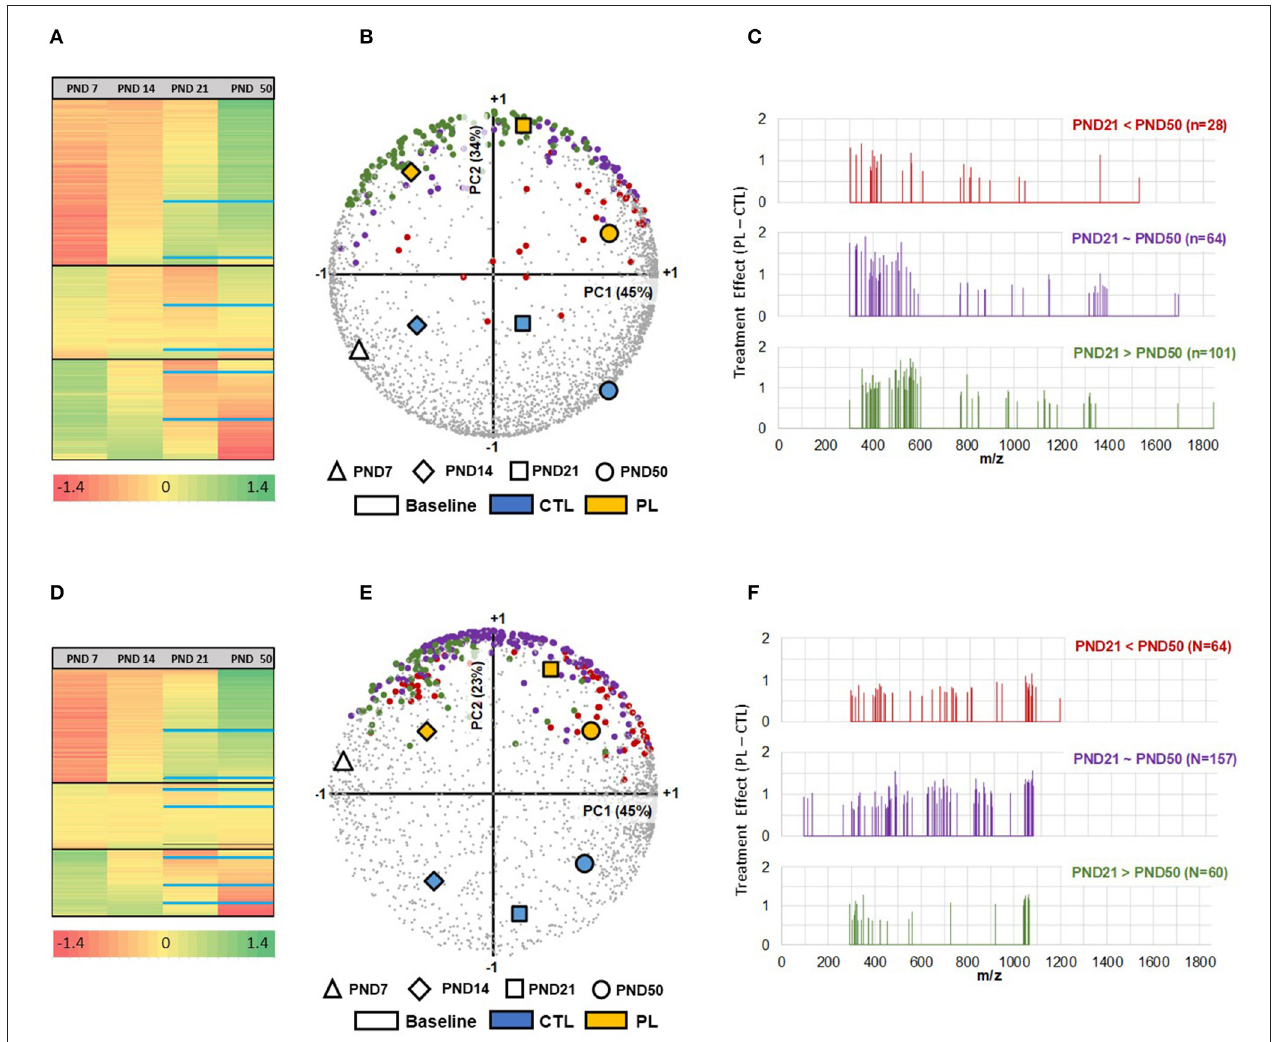
FIGURE 2 | Neurodevelopmental changes in brain lipidome and the impact of the PL supplementation. (A,D) In total, three developmental clusters (increasing, no change, and decreasing with age) of brain lipidome were detected using HCA, shown for positive and negative ionization mode, respectively. The black solid lines divide the three clusters within the HCA heatmap. Within each cluster, 3 additional subclusters were identified, divided by blue solid lines within each cluster, for PND 21 and PND 50. PCA Biplot of first and second principal components with Treatment x Age positioned for m/z detected in (B) positive ionization mode ( n = 3,108) and (E) negative ionization mode ( n = 2,133). PC1 (plotted on x-axis), accounting for 45% in both modes, is highly associated with developmental age, whereas PC2 (plotted on y-axis), accounting for 34% in positive and 23% in negative modes, respectively, is strongly differentiating the two treatments, revealing that more than 70% of total variability is explained by the independent contributions of age and treatment effects. Selected m/z are further colored accordingly to their evolution pattern between PND 21 and PND 50 (C,F) . The m/z identified by differential analysis at PND 21 in positive and negative ionization modes were subcategorized into molecular species that increased (red), decreased (green) and stayed the same (purple) at PND 50 compared to PND 21. The selected hits 193 ( + ) and 281 (-), are shown as a function of m/z. The x-axis corresponds to the mass range, whereas the y-axis shows the peak intensity difference between experimental groups expressed in log. All analysis were performed on z-scores of log-transformed peak